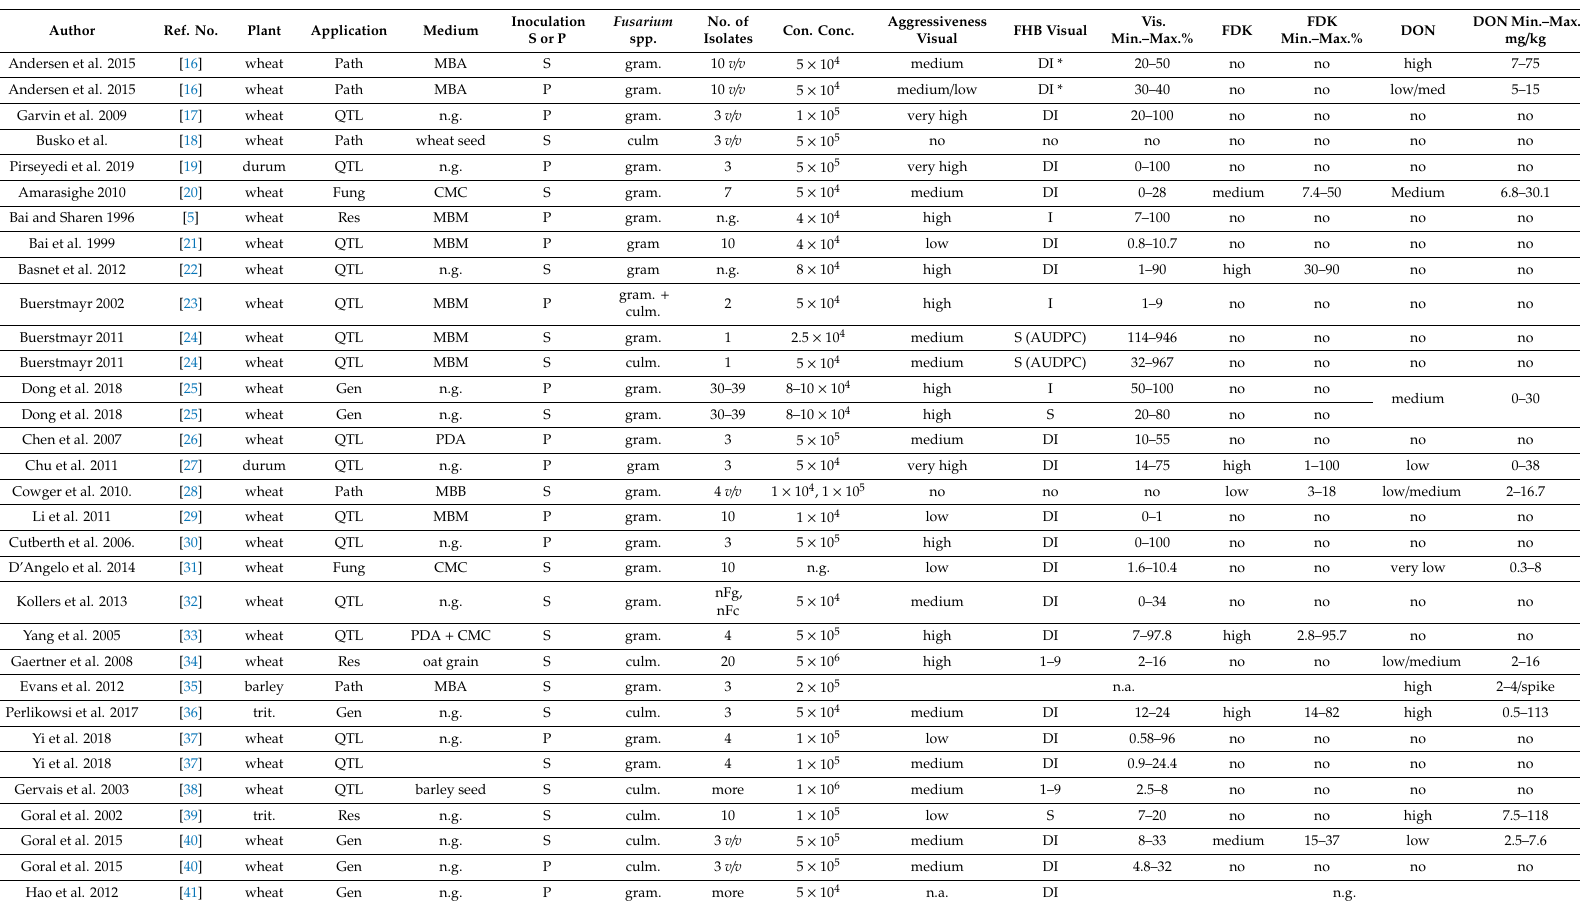
Table 1. Experimental data of Fusarium resistance and pathogenicity tests from papers using mixtures of